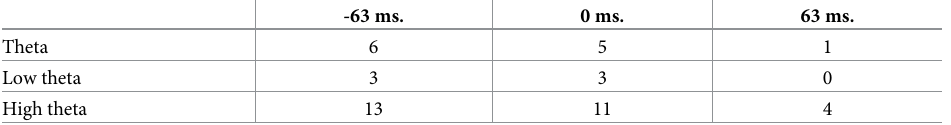
Table 1. Number of correlations and dependencies detected for sliding windows between -63 ms and 63 ms in Theta frequency bands. -63 ms.